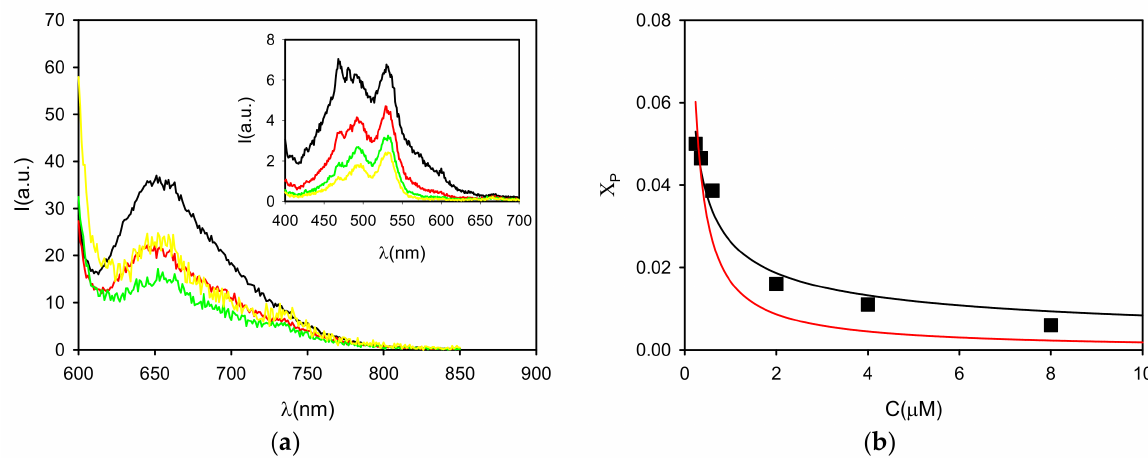
Figure 3. ( a ) Fluorescence spectra of P in buffered neutral water (pH = 7) at concentrations 16, 8, 4 and 2 µ M upon λ exc = 590 nm (black, red, green and yellow lines, respectively). The excitation spectra of the four solutions ( λ em = 720 nm) are shown in the inset (same color line). ( b ) The fluorescence quantum yield is used to calculate the molar fraction of P ( χ P ) and it is plotted as a function of concentration (black squares). These data are fitted using either a dimeric (black line K 2 = 7 × 10 8 M − 1 ) or an isodesmic model (red line, K = 5 × 10 7 M − 1